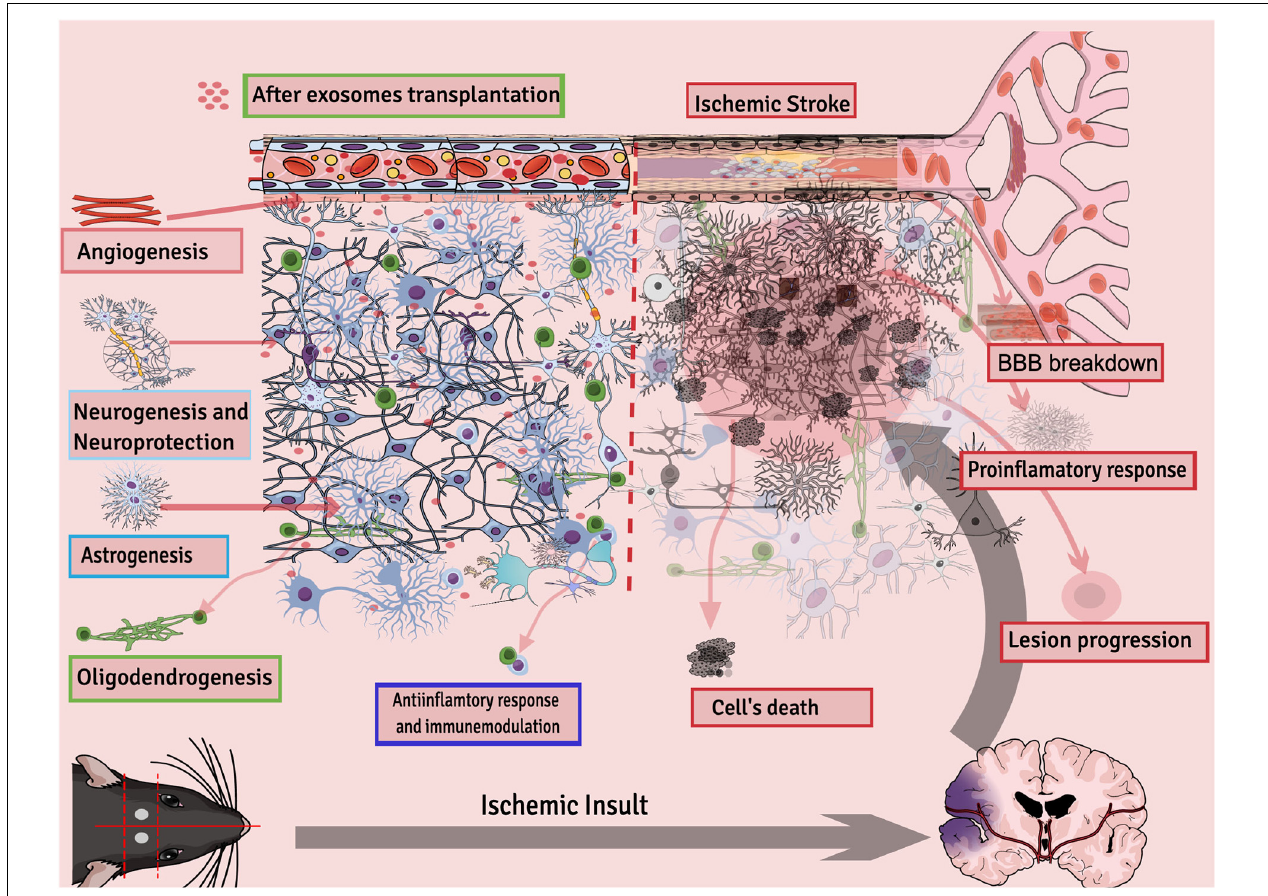
FIGURE 2 | Different processes regulated by exosomes after ischemic